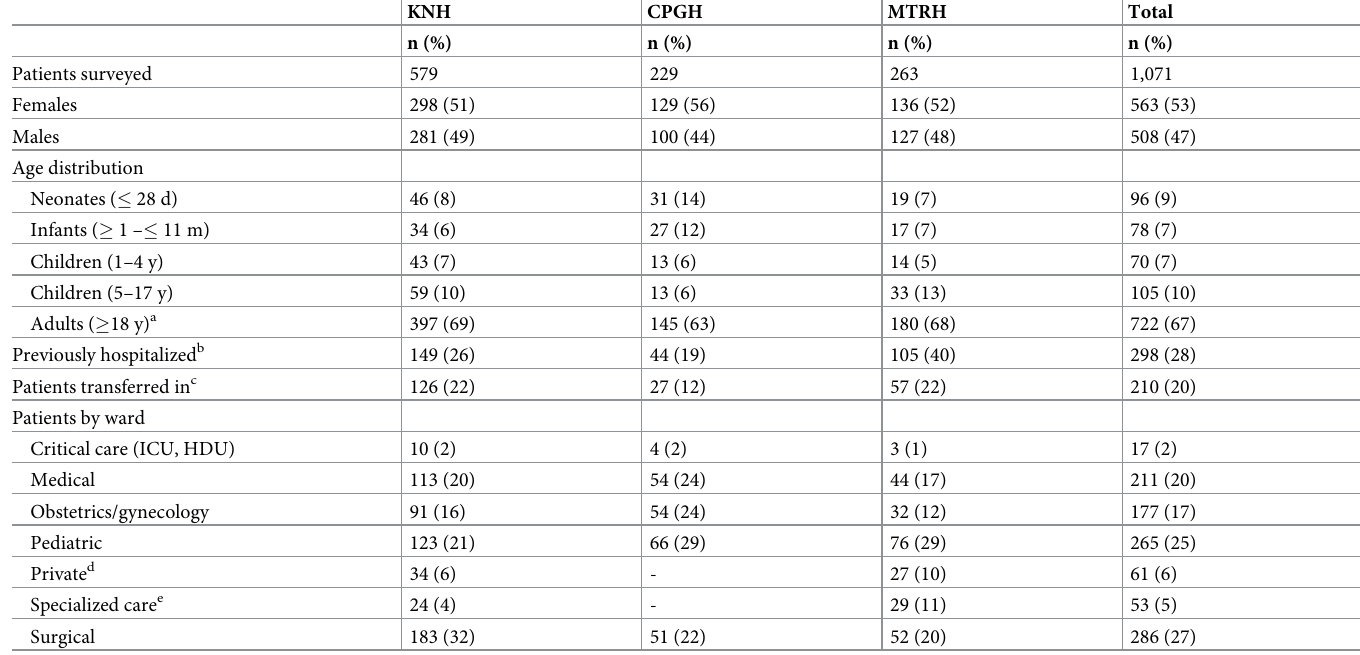
Table 1. Participant characteristics at Kenyatta National Hospital (KNH), Coast Provincial General Hospital (CPGH) and Moi Teaching and Referral Hospital (MTRH), 2017–2018,